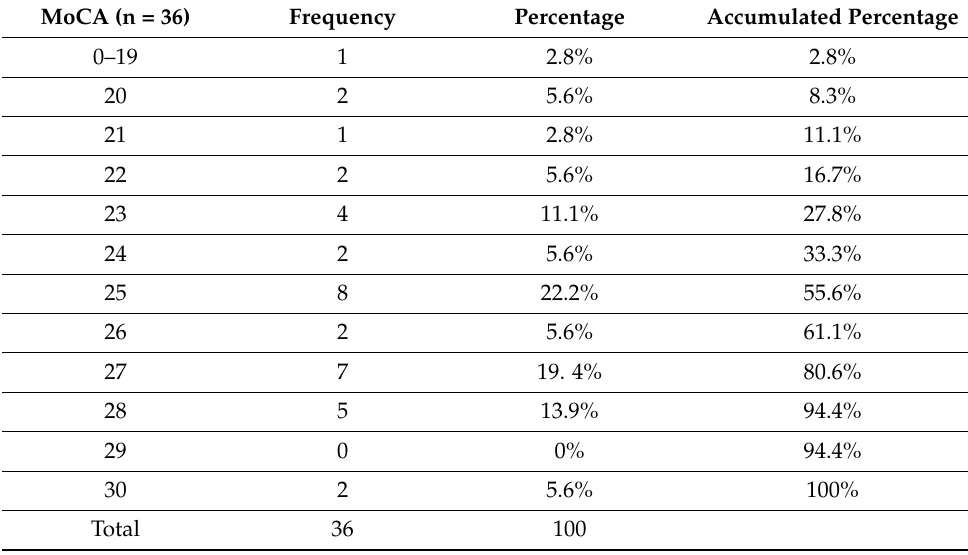
Table 5. Results regarding the participants’ performance on the MoCA